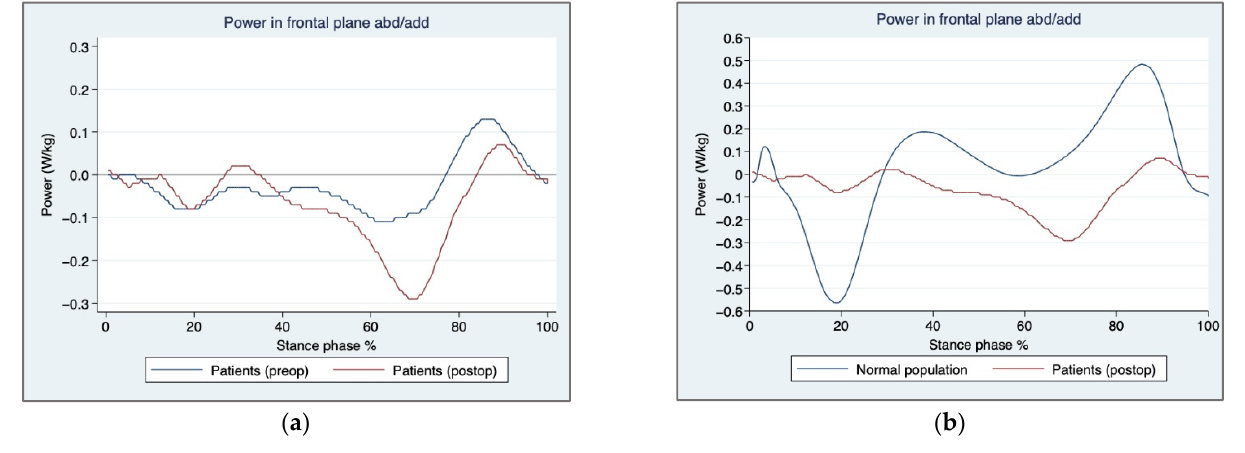
Figure 3. Hip power in the frontal plane: ( a ) Pre- and postoperative hip power absorption and generation in patients during stance, ( b ) Normal population and postoperative patients, hip power absorption and generation during stance.